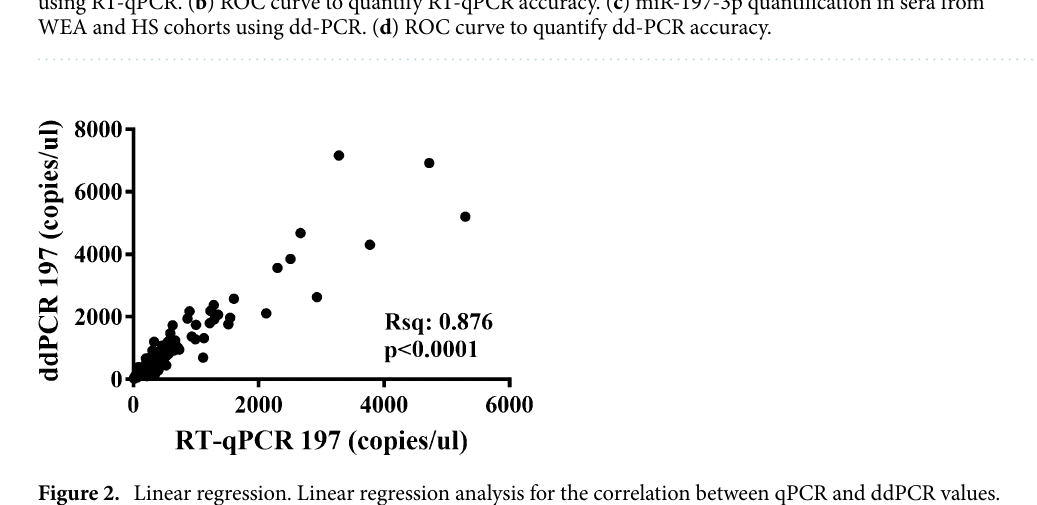
Figure 2. Linear regression. Linear regression analysis for the correlation between qPCR and ddPCR values.